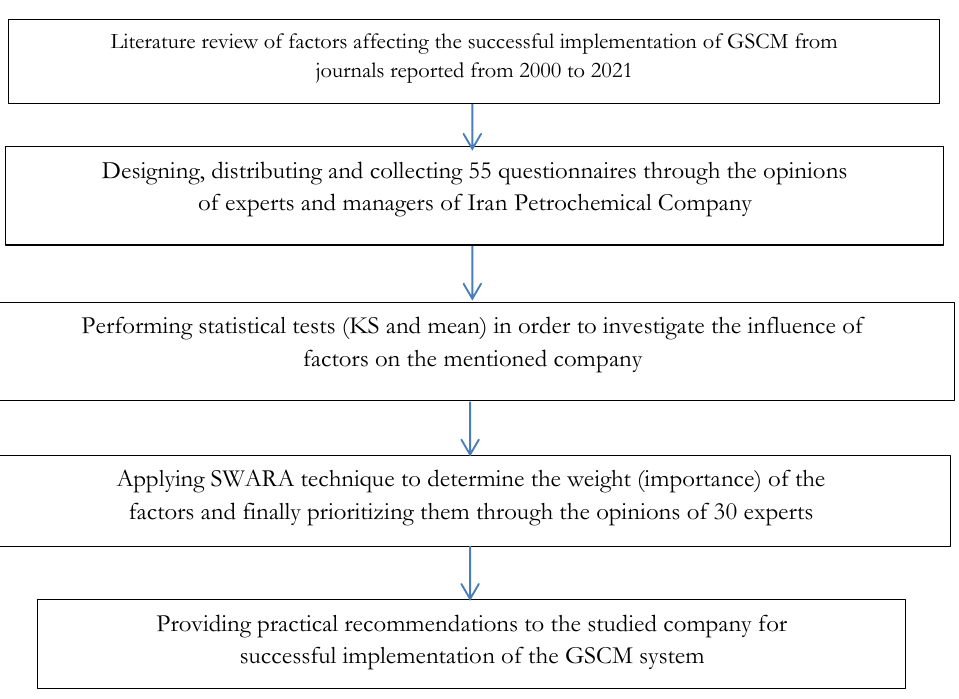
Fig. 1. the flowchart of the methodology presented in this